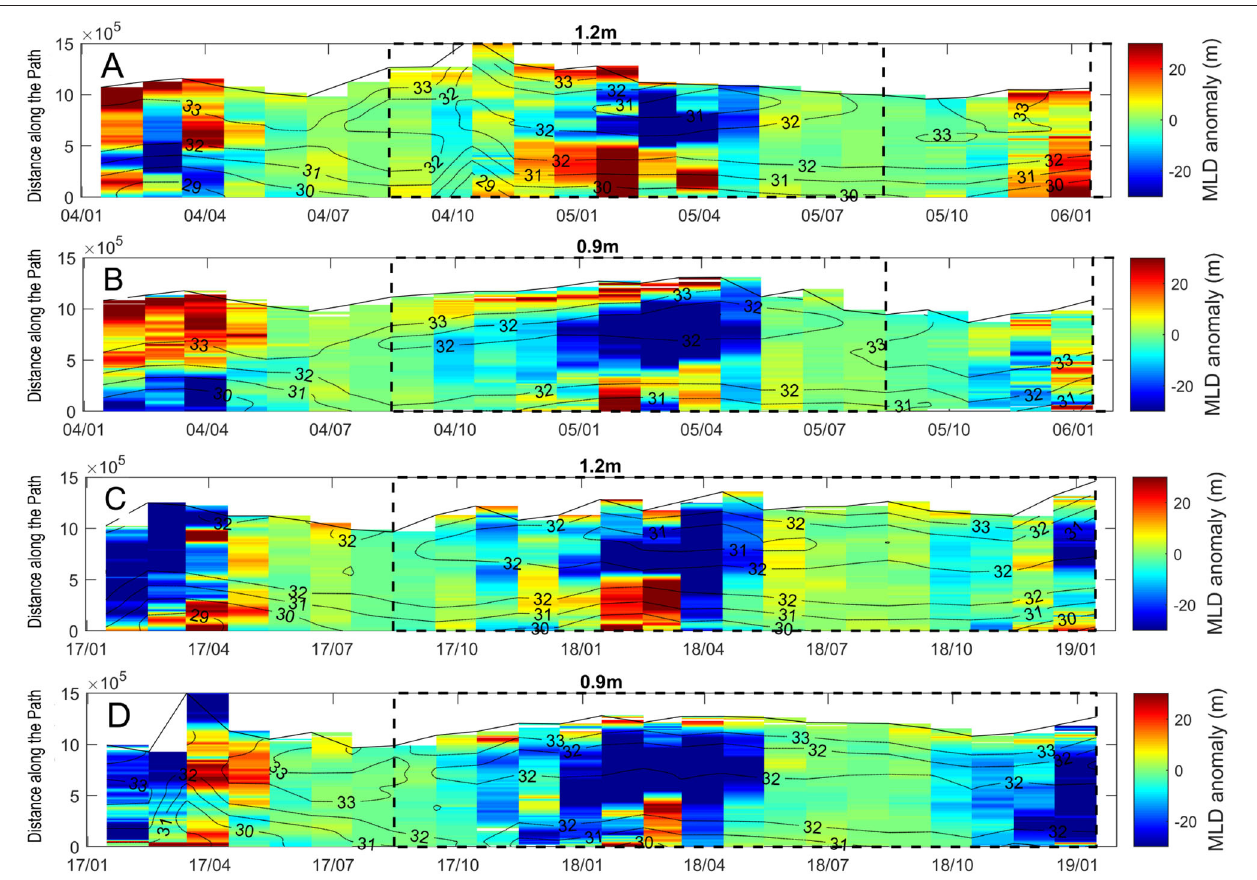
FIGURE 7 | Monthly mixed layer depth anomaly extracted during the two large meander periods shown in color as a function of time and distance along the Kuroshio path with different definitions of the Kuroshio axis with the SSH values for (A,C) 1.2 and (B,D) 0.9 m. (A,B) shows LM 2004–2005 and (C,D) LM 2017–2019. Black dashed line indicates the large meander periods. Black dotted contour indicates the